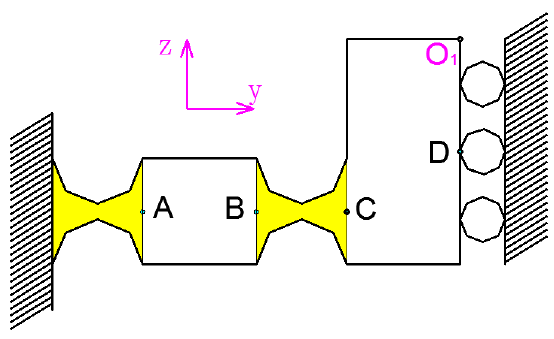
Figure 13. Analysis of z -direction hinge.